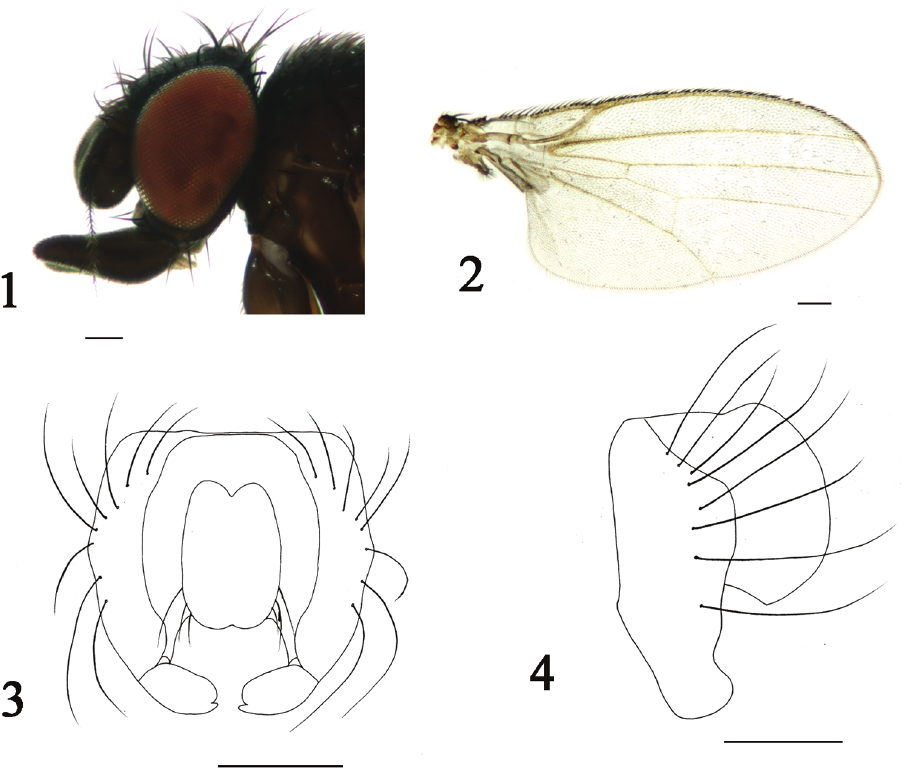
Figures 1–4. Phyllomyza guangxiensis sp. n. (male). 1 Head, lateral view 2 wing 3 epandrium, cerci, and surstyli, posterior view 4 epandrium, cerci, and surstyli, lateral view. Scale bars: 0.1 mm.